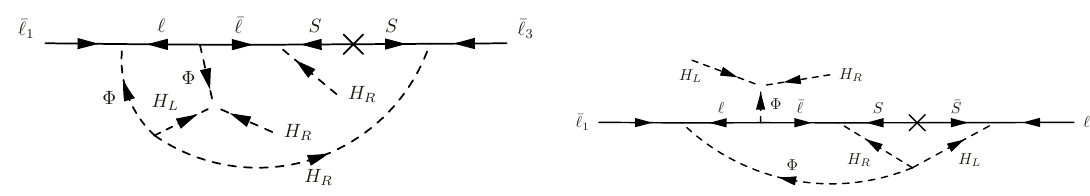
Figure 8 . Two-loop diagrams correcting the mass and decay rate of the dark matter, N 1 , when the neutrino masses are generated by the exchange of a heavy singlet S , and the charged lepton masses are generated by the exchange of a heavy scalar, Φ . The diagrams are UV completions to the EFT diagrams of figure